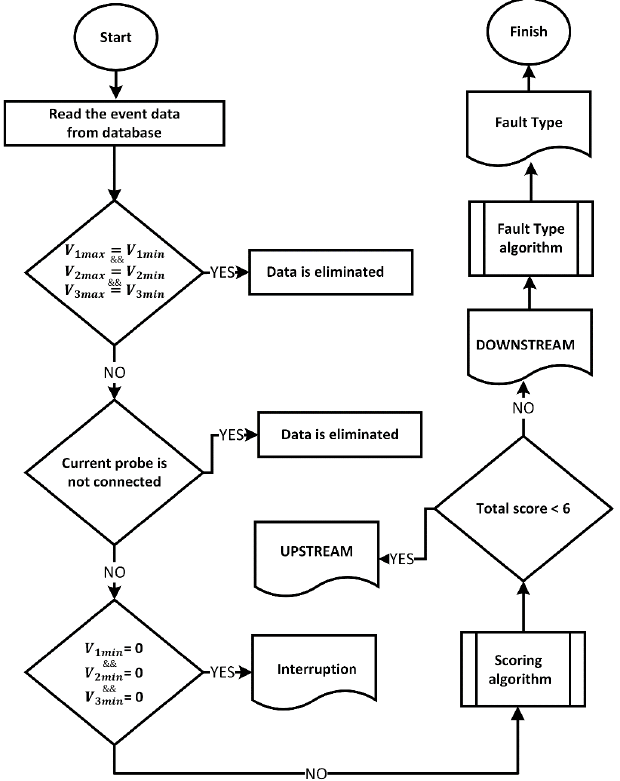
Figure 2. Flowchart diagram of the proposed method.